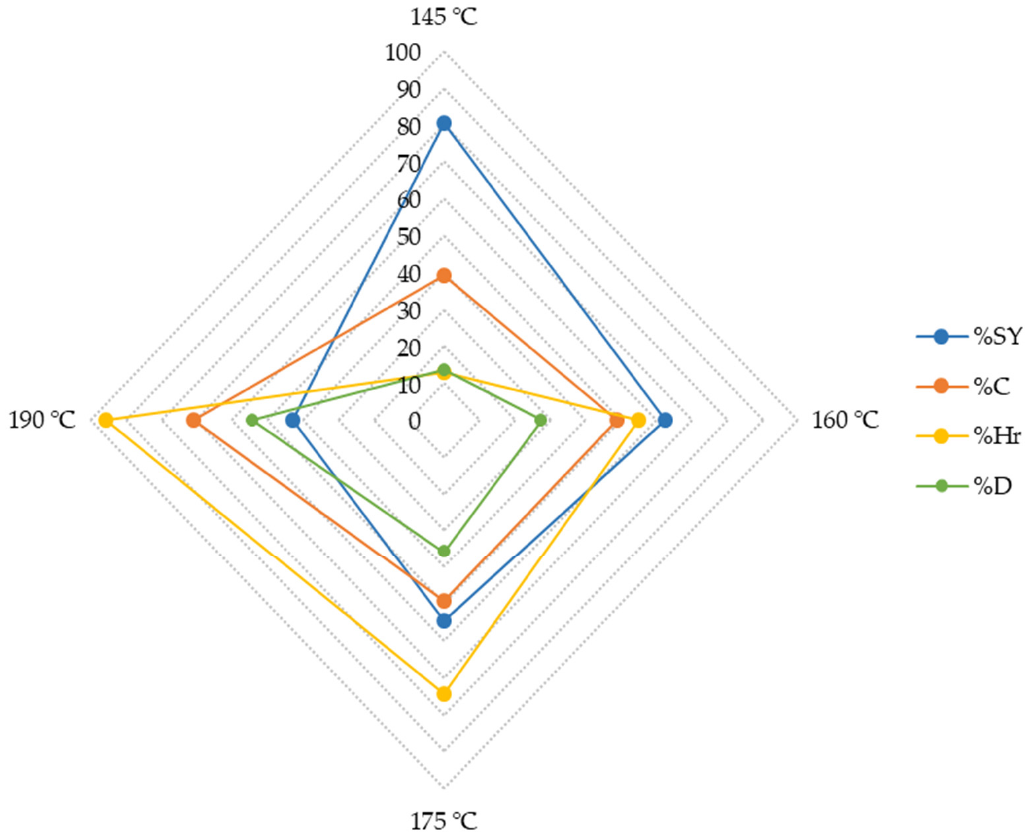
Figure 4. Solid yield (%SY), percentage of cellulose in the processed solid (%C), percentage of hemicellulose removal (%Hr) and percentage of delignification (%D) achieved in fractionation treatments performed at diverse temperatures. The cellulose content of the solids from fractionation (measured by %C) increased with temperature due to the lower susceptibility of this fraction to hydrolysis